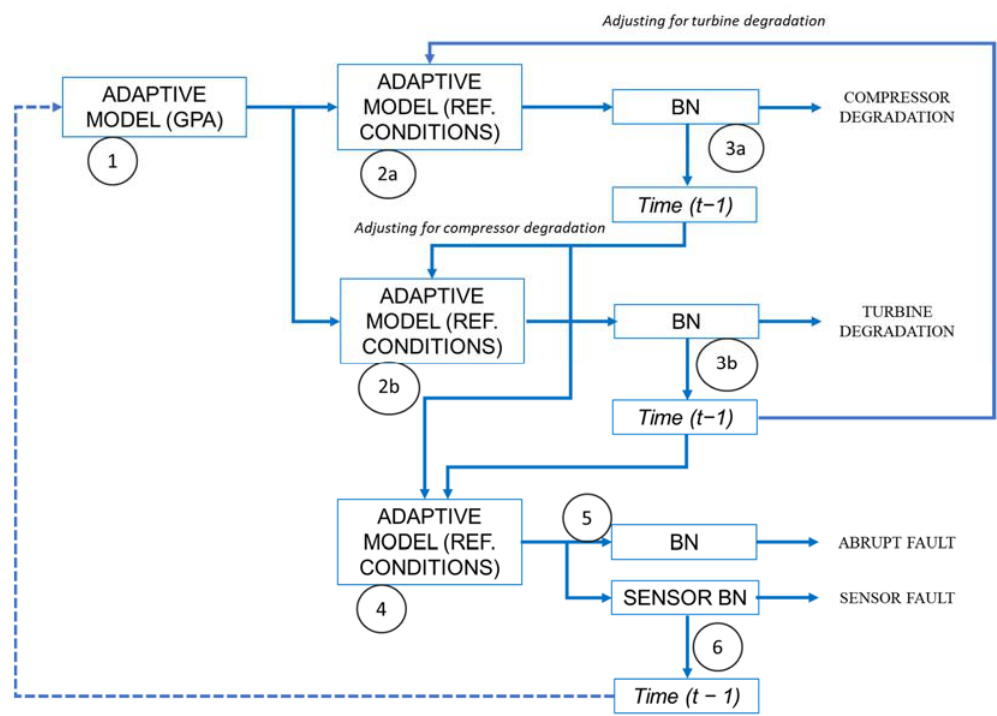
Figure 2. Schematic diagram of the multi-layer diagnostic system based on adaptive performance model and Bayesian networks.